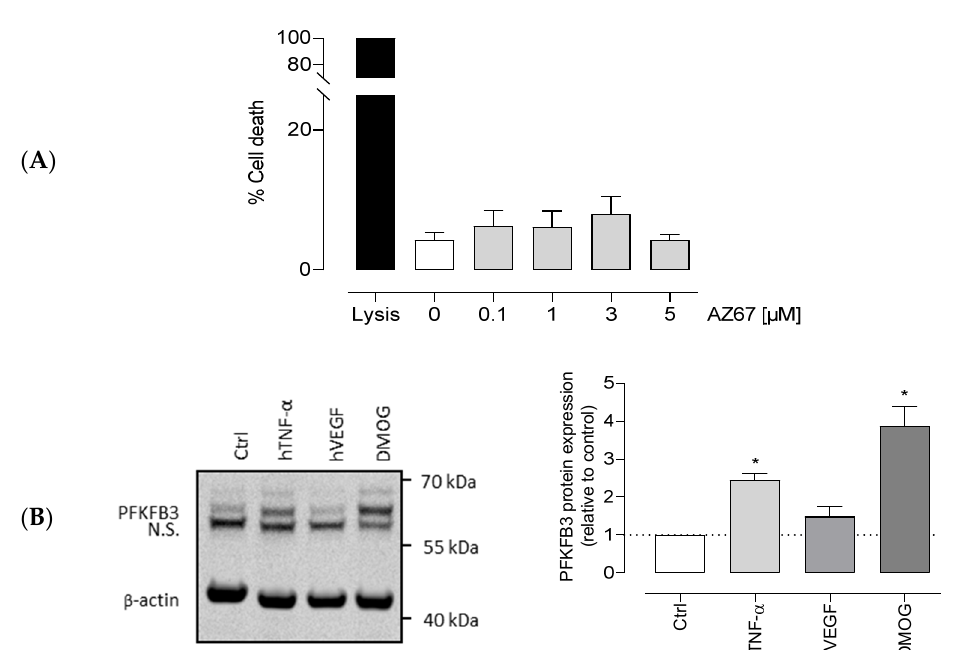
Figure 2. Viability of HAOEC upon AZ67 treatment and PFKFB3 expression with different stimuli. ( A ) AZ67 does not affect the viability of HAOEC. Cells were treated for 24 h with either vehicle or different concentrations of AZ67 (0.1, 1, 3, 5 µ M). AZ67did not show cytotoxic effects up to 24 h treatment compared to vehicle. Data are represented as mean ± SEM, N = 5, p > 0.05 (one-way analysis of variance (ANOVA)). ( B ) PFKFB3 protein expression in HAOEC. Western blot analyses and densitometric quantification of PFKFB3 protein levels in HAOEC lysates with different stimuli. HAOECs were seeded in 24-well plates and further stimulated with 20 ng/mL hTNF- α , 10 ng/mL hVEGF, or 1 mM DMOG for 24 h. Expression was normalized per independent experiment to β -actin and expressed relative to control. All data points represent normalized averages obtained from 3-4 independent experiments and are presented as mean ±SEM. N.S—nonspecific band. * p < 0.05 vs. control (one-way ANOVA, followed by the Dunnett T3 test).